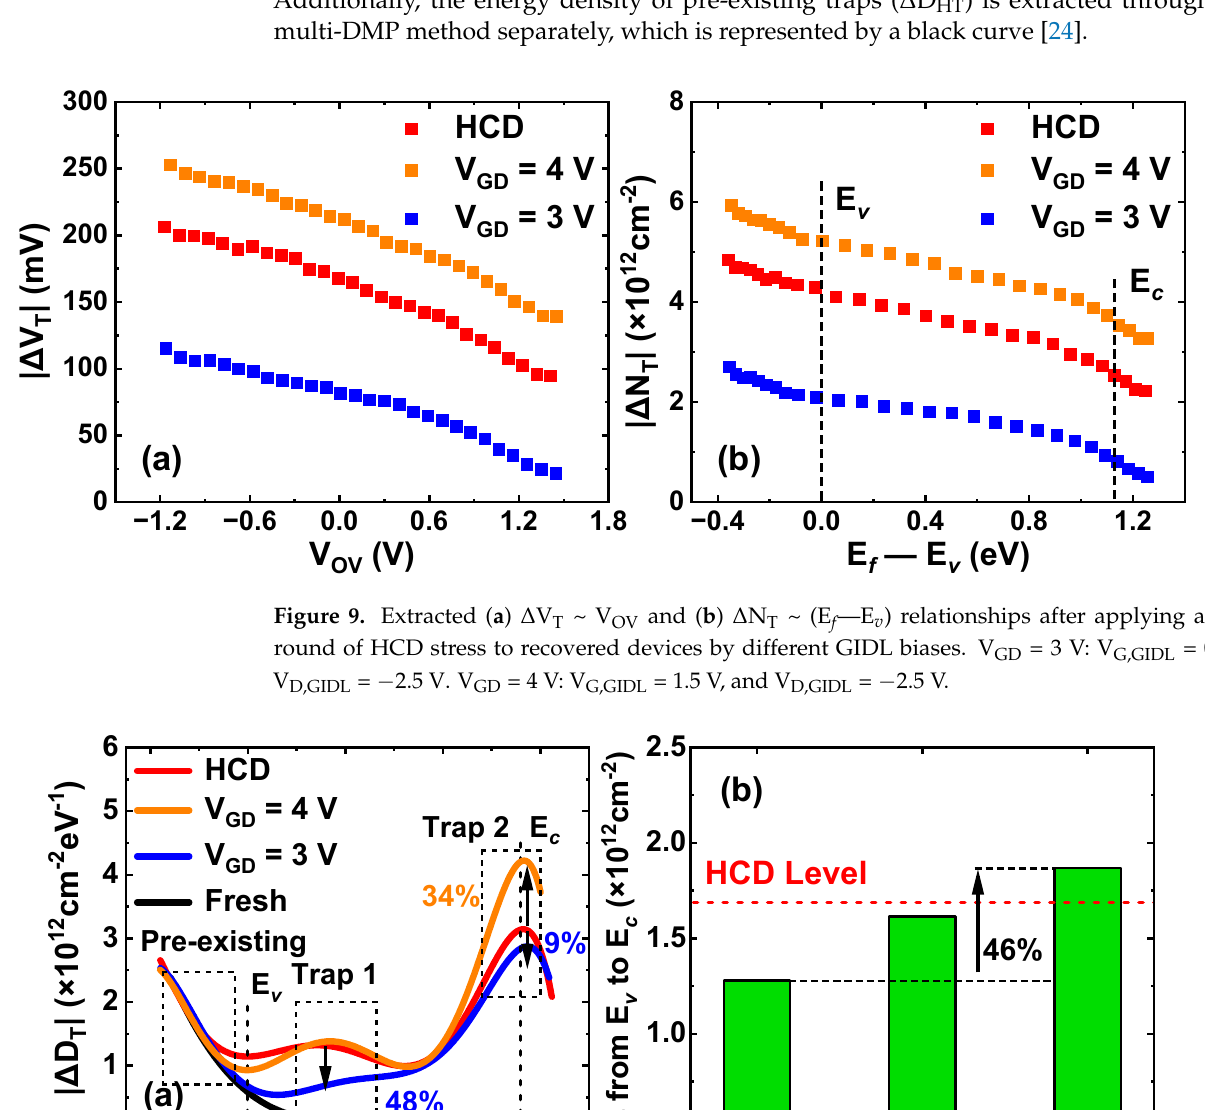
− 2.5 V; V G,GIDL varies from